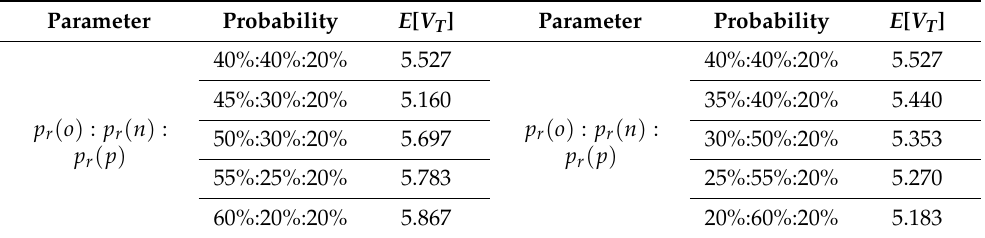
Table 7. Risk probabilities of the estimated project synergy values in optimistic, normal, and pes- simistic circumstances. Currency: US$ Unit: million dollars.